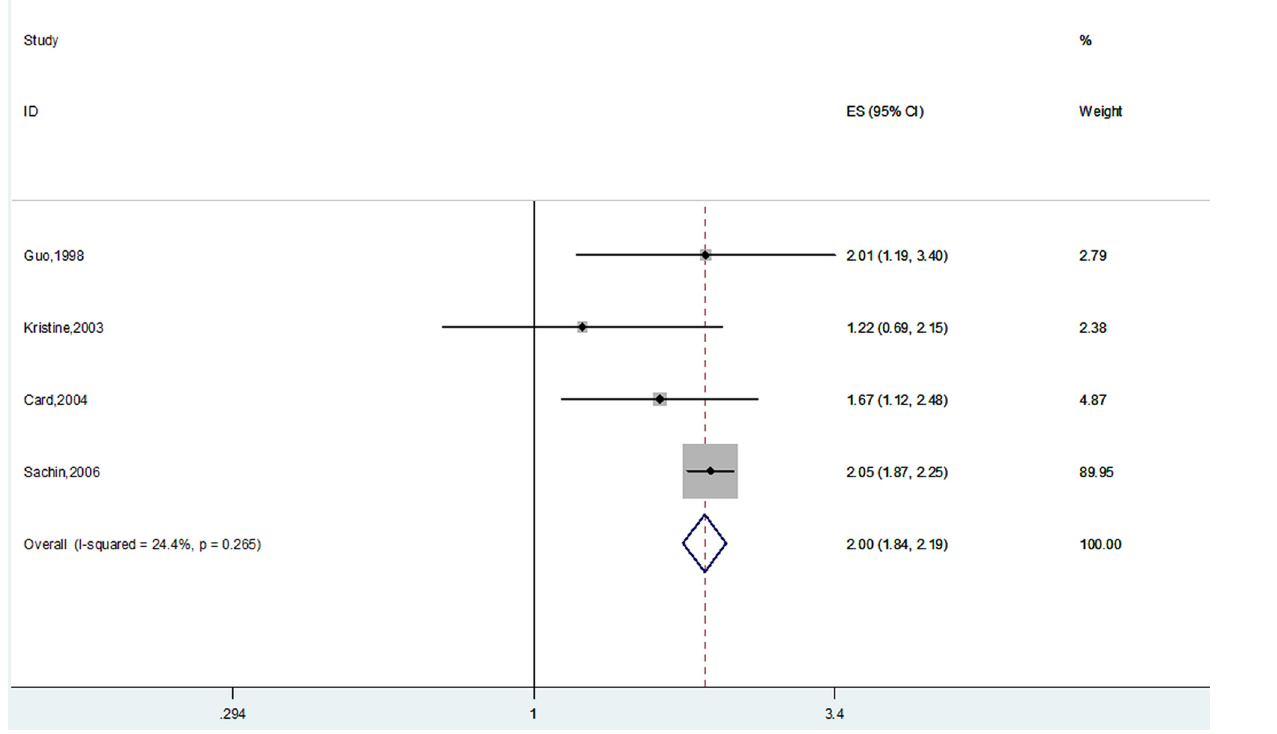
Fig 3. Forest Plot of RR with CI for Opioid Use and Hip Fracture Risk.